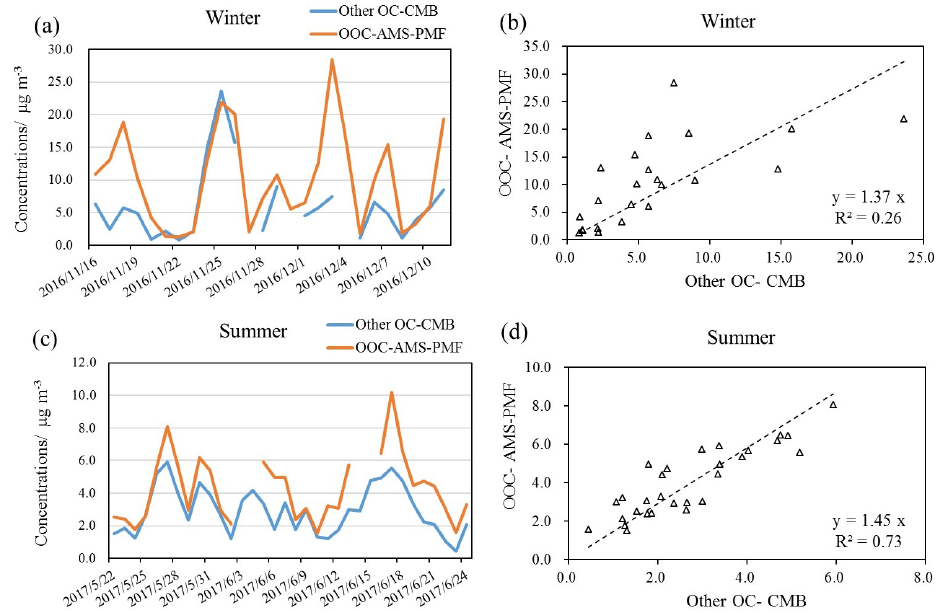
Figure 9. Time series of mean values for other OC estimated by the CMB model and OOC estimated by AMS-PMF in winter (a) and summer (c) ; correlation relationship between other OC estimated by the CMB model and OOC estimated by AMS-PMF in winter (b) and summer (d)